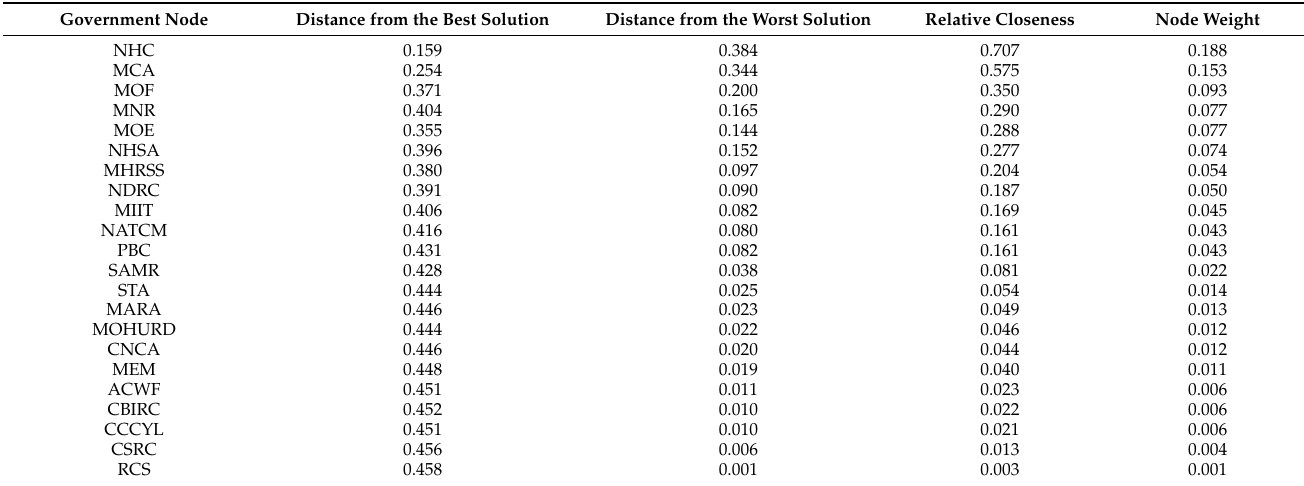
Table 5. The related calculation results of the node weight. Government Node Distance from the Best Solution Distance from the Worst Solution Relative